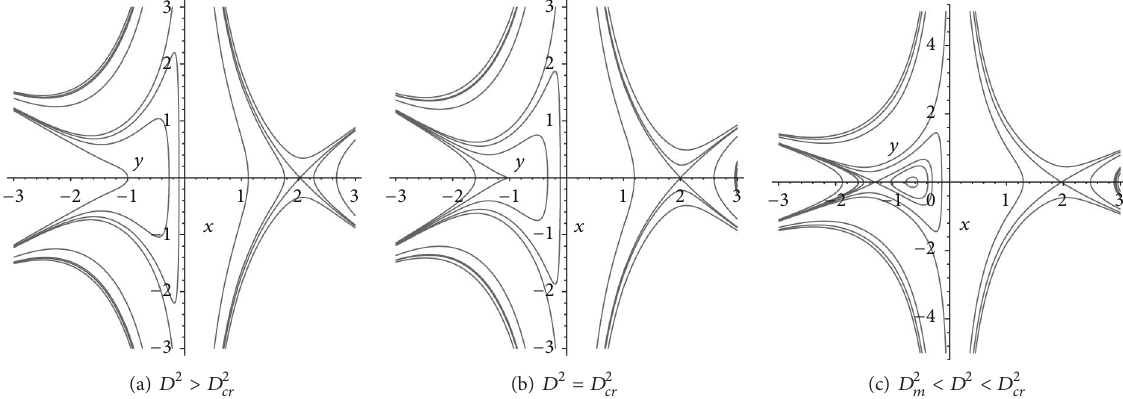
Figure 3: The phase portraits of system (6) for 𝑛 = 2𝑚 , 𝛽 < 0 , 𝐺 1 < 0 , and 𝜎 > 0 .